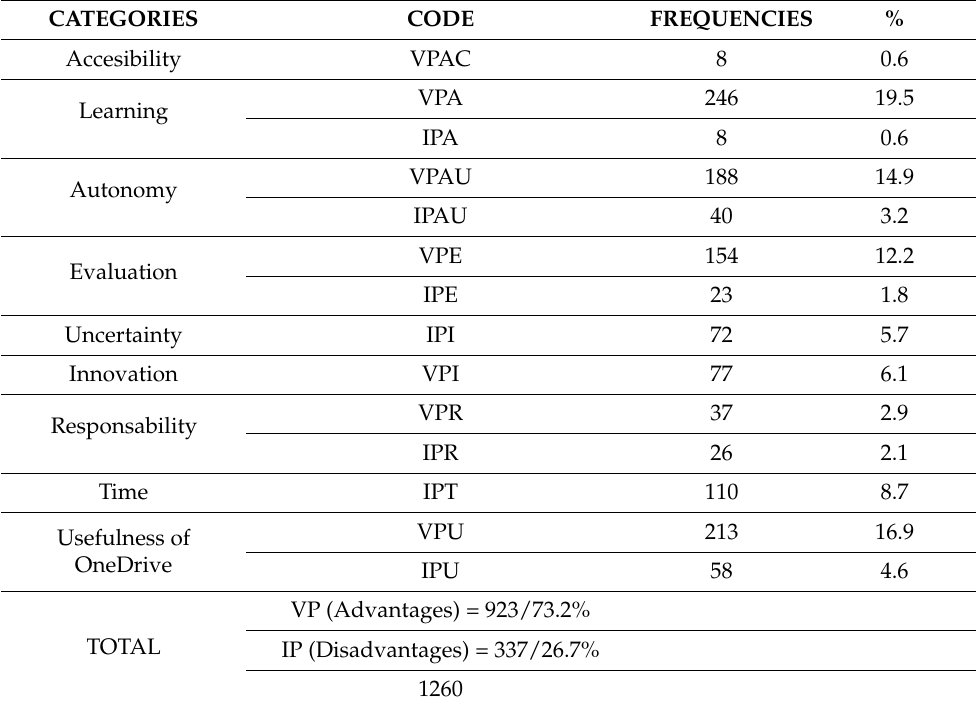
Table 2. Categories, codes and frequencies of the opinions of the students about the digital portfolio.